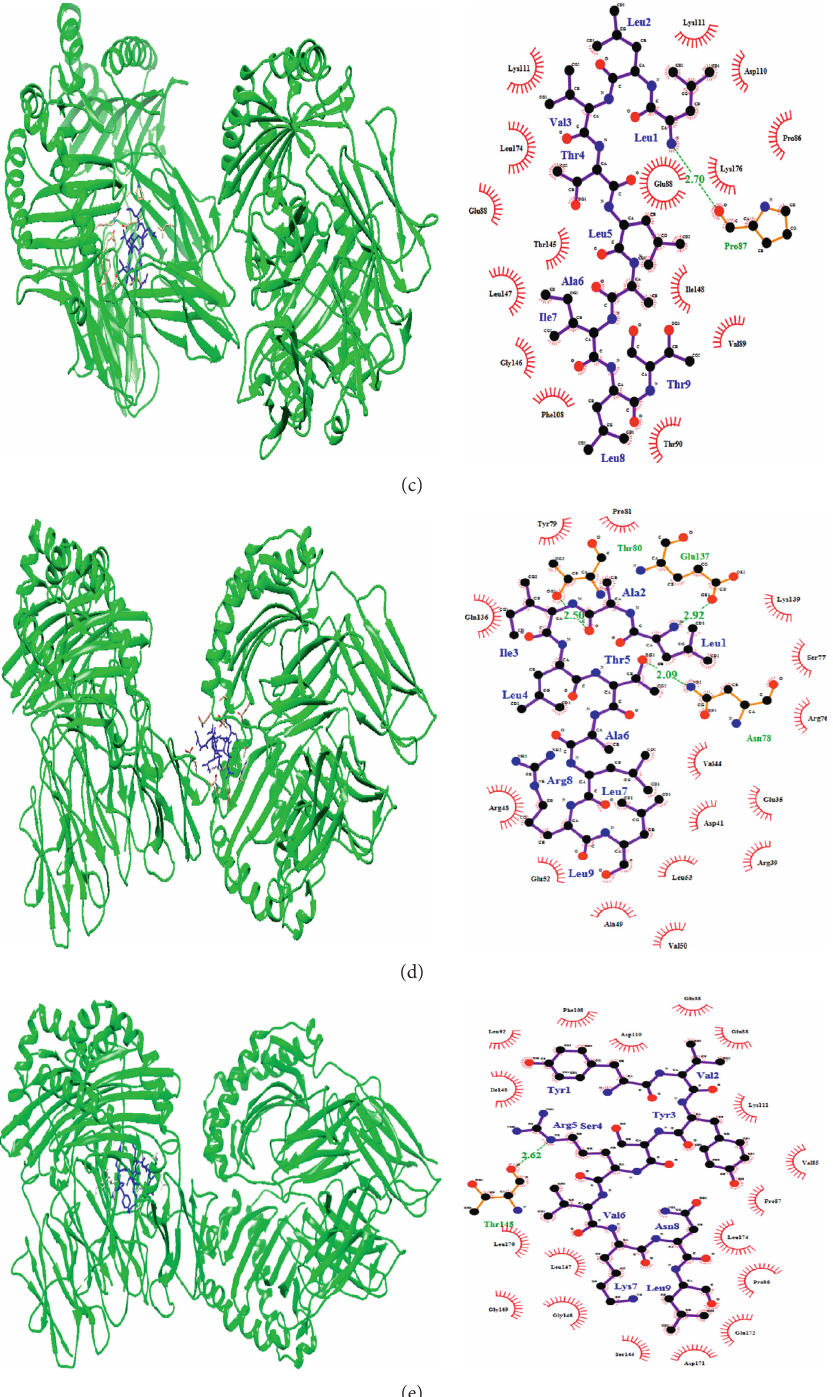
Figure 6: (Left) docking sites of predicted peptide against selected MHC-II (1AQD) receptor. HLAs are shown in ribbon (green) form and epitope is shown in stick (blue). (Right) interacting residues between ligand and receptor. H-bond interaction is shown in green colour. (a) VLLFLAFVV-1AQD; (b) FLAFVVFLL-1AQD; (c) LLVTLAILT-1AQD; (d) LAILTALRL-1AQD; (e)